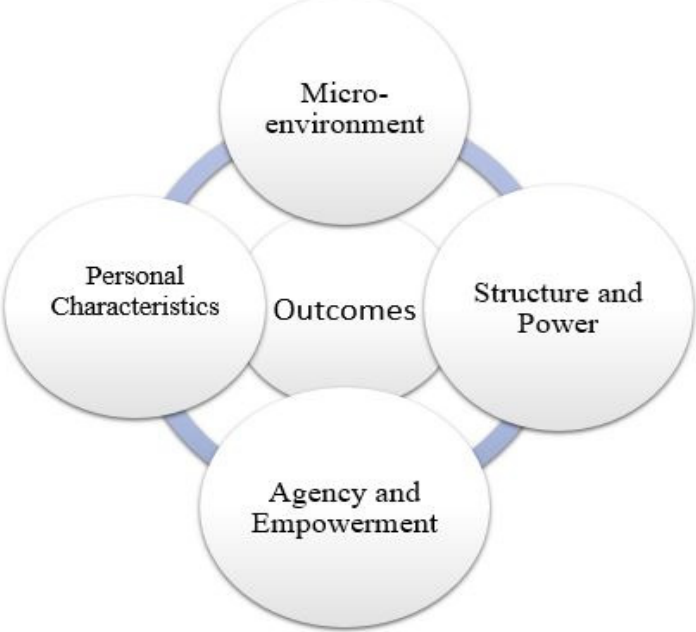
Figure 1. An integrated model of human action and conditions.